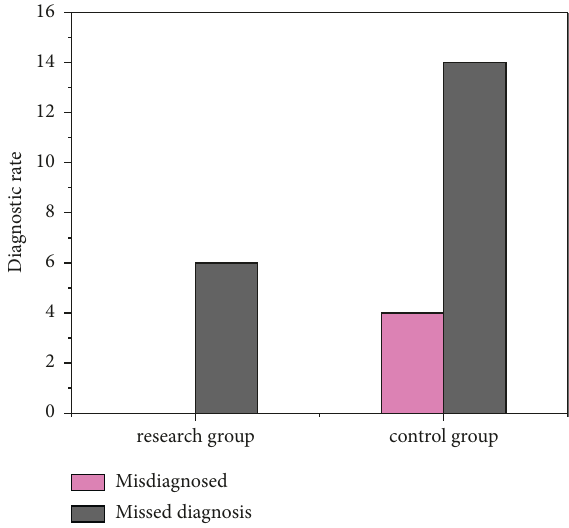
Figure 3: Comparison of misdiagnosis and missed diagnosis be- tween the two